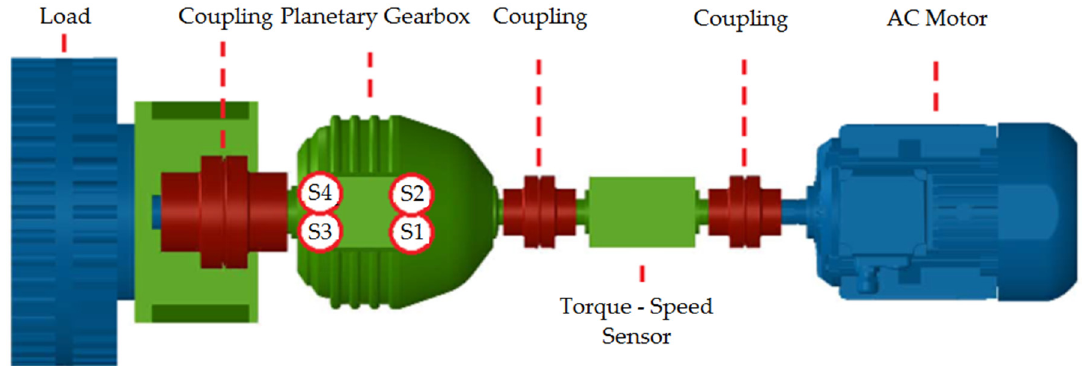
Figure 19. A schematic of the experimental planetary gearbox test rig.